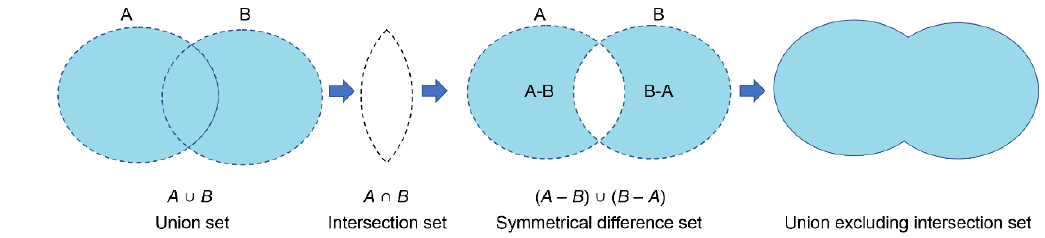
Figure 12. Symmetrical difference set.